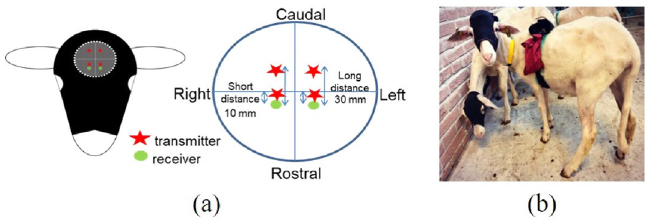
Figure 6. ( a ) The configuration of optical probes on the surface of sheep head: red stars represent the transmitters and green circles represent the receivers. ( b ) Sheep equipped with fNIRS